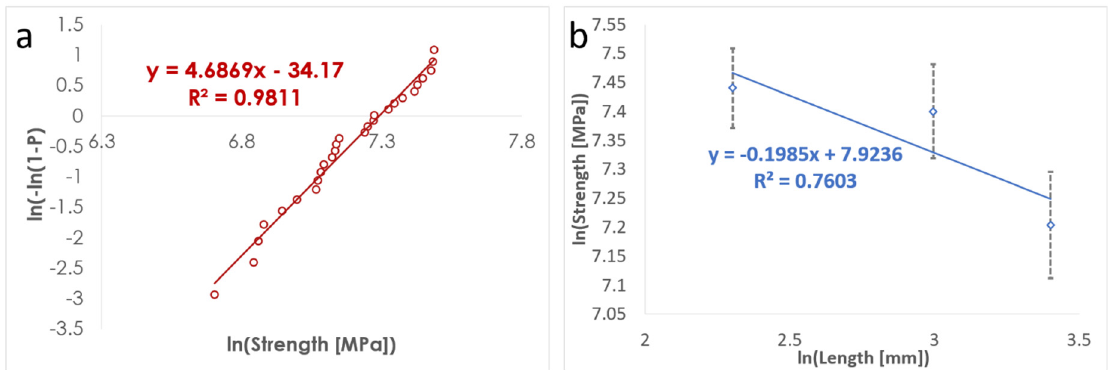
critical length for the fibres, 𝜎(cid:3364) ((cid:3013)